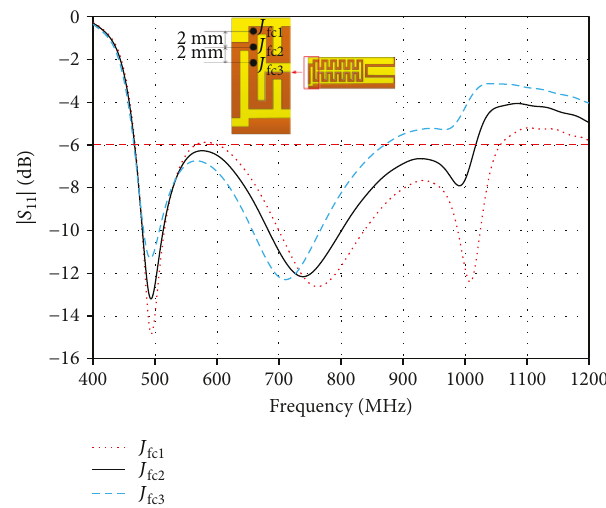
| of the proposed MD-loaded MLA for 11